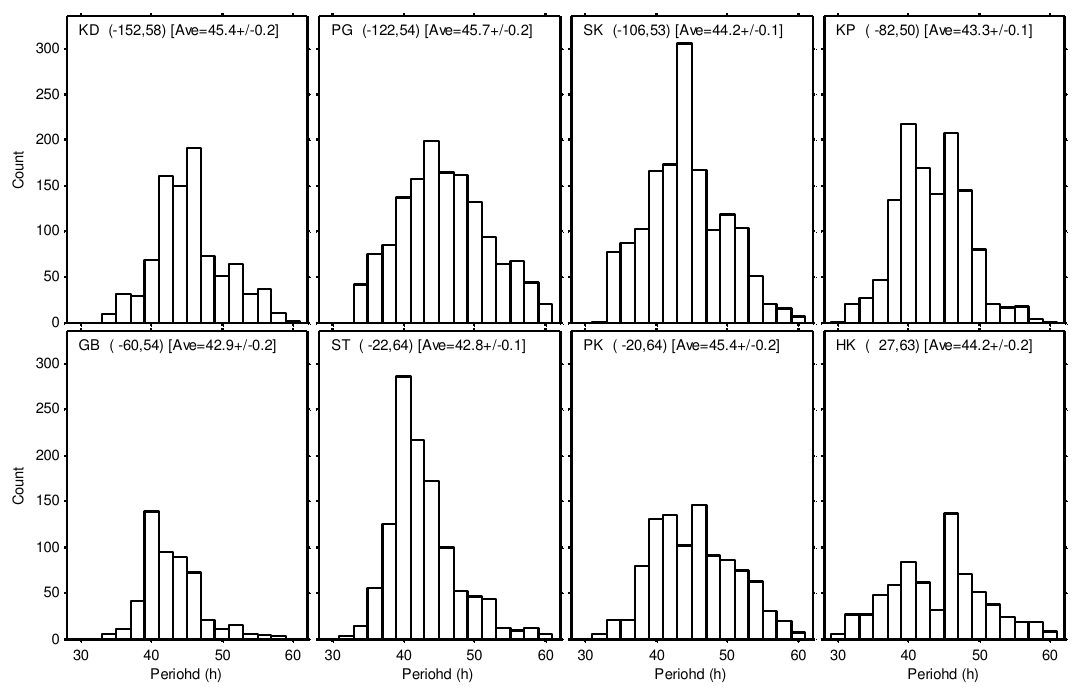
Fig. 7. Distribution of the instantaneous hourly periods of the QTDW for the meridional flow in summer for different radars, as indicated by the abbreviations on the top left-hand corner of each panel.